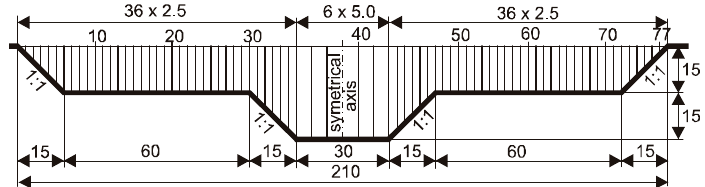
Figure 2. Location of measurement points in the cross-section (dimensions in cm).